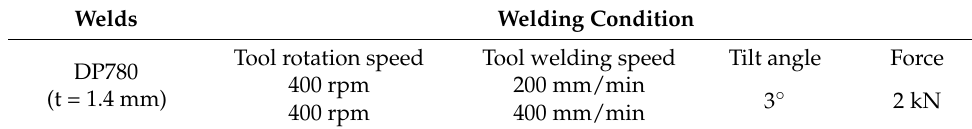
Table 2. FSW parameters used for the current study.